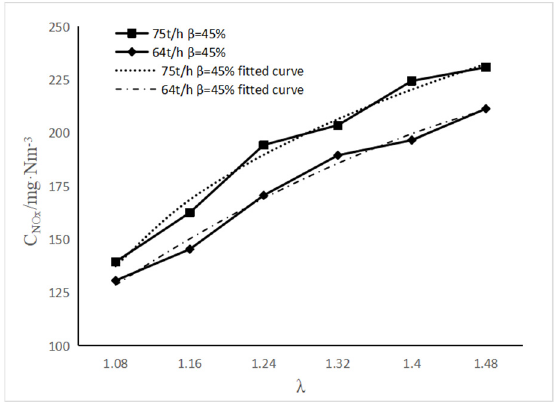
Figure 2. Effect of λ on C NOx in combustion flue gas.